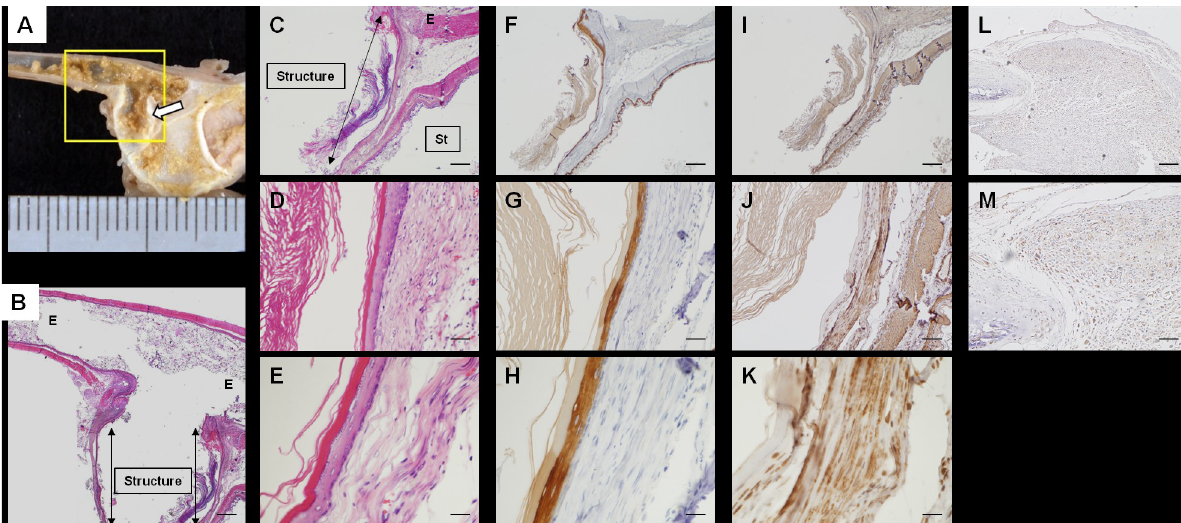
Fig 5. Assessment of the structures at 30 days after transplantation. A: The transplanted site. B: Hematoxylin and eosin (HE) staining at the site shown in A (yellow box). Scale bar = 500 μ m. C-E: HE staining of the transplanted structure. Scale bar = 500 μ m (C), 100 μ m (D), and 50 μ m (E). F-H: Immunohistochemical staining of the transplanted structure with anti-pan-cytokeratin. Scale bar = 500 μ m (F), 100 μ m (G), and 50 μ m (H). I-K: Immunohistochemical staining of transplanted structure with anti- α SMA. Scale bar = 500 μ m (I), 100 μ m(J), and 50 μ m (K). Arrows: transplanted structure, E: esophagus, St: stomach. Immunohistochemical staining of the transplanted structure with anti-HLA class 1 ABC. Scale bar = 200 μ m (L), 100 μ m (M).